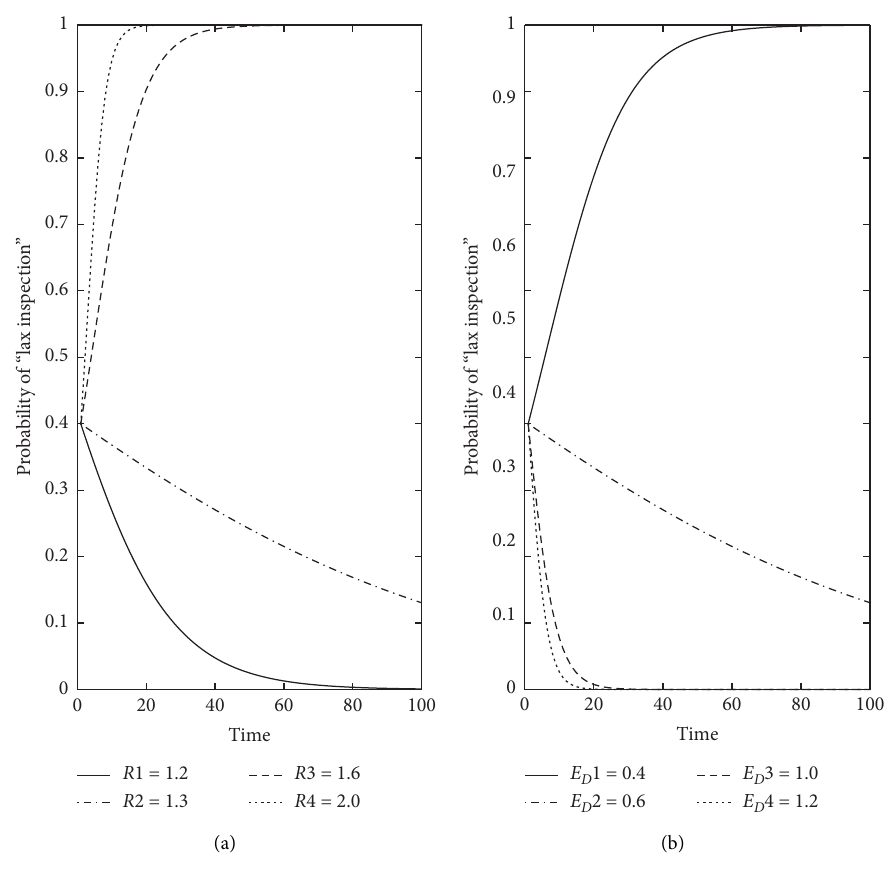
Figure 9: The effects of rent-seeking benefits and psychological